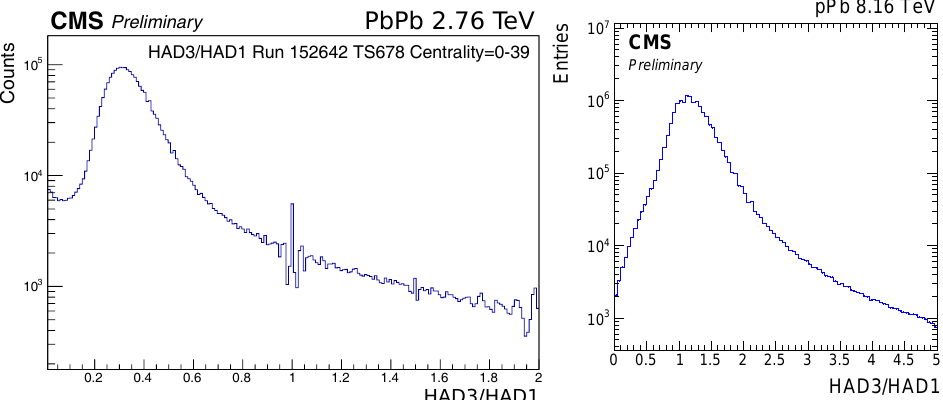
Figure 3. Comparison of signal ratio distributions between 2.76 TeV PbPb ( left ) and 8.16 TeV pPb collisions ( right )